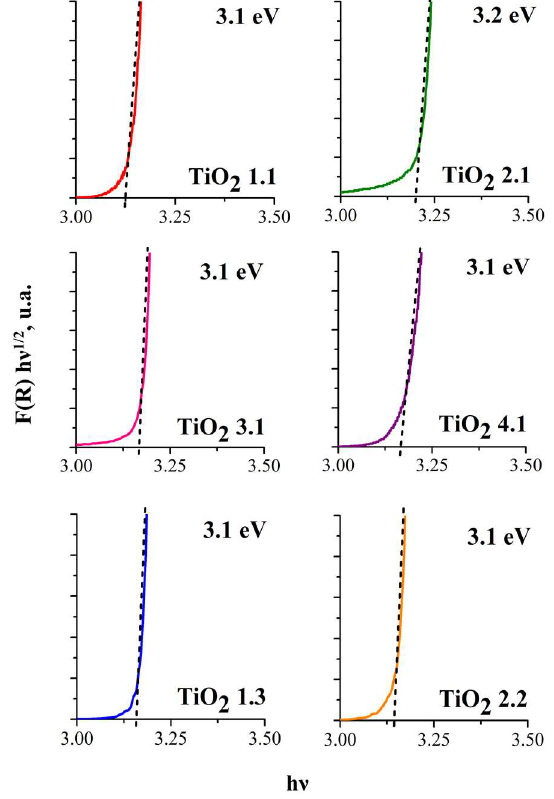
Figure 6. Tauc plots for the synthesized titania materials and their corresponding band gap